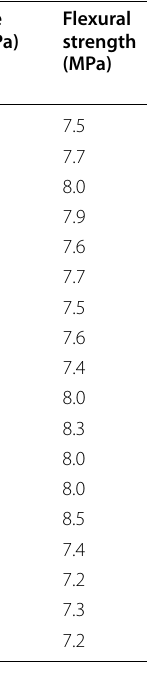
Table 2 Compressive and flexural strengths of NFRCCs from Yun et al., (2022) Plant